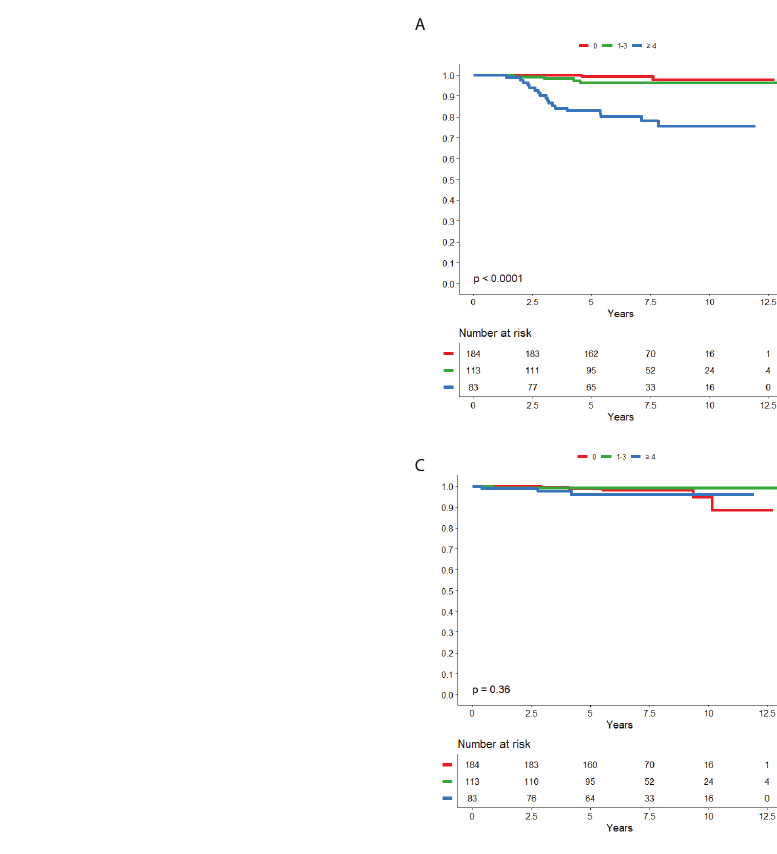
FIGURE 5 Nodal status in relation to BCSS (A) , DRFS (B) and LRFS (C) respectively in patients that was treated with